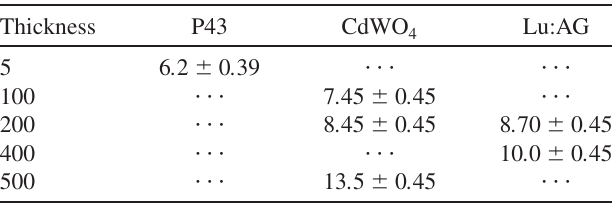
TABLE II. Width of the PSF (rms) of the x-ray camera with several screens of different thicknesses (all dimensions are in (cid:1) m ). The error is given by the standard deviation of the fitted width per line on the digital image.